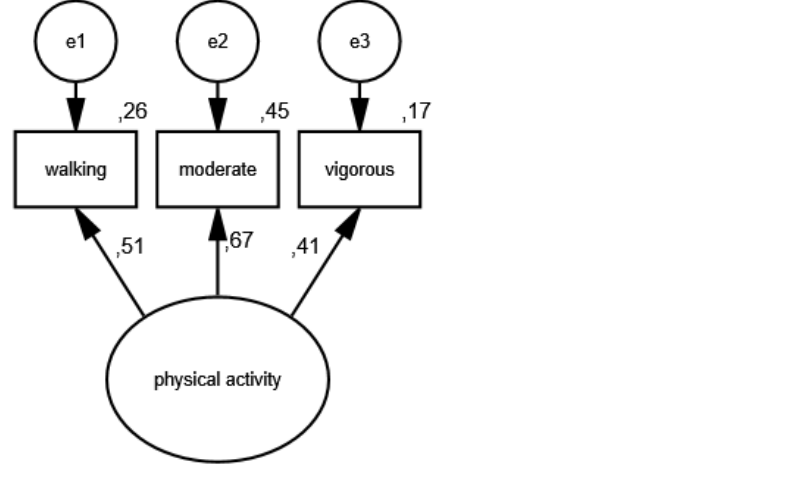
Figure 2. Standardized effects of the model of physical activity measurement in the group of men . As a result of the estimation, the following measures were obtained: CMIN/DF = 1.75; GFI = 0.99; AGFI = 0.99; NFI = 0.99; RFI = 0.95; IFI = 0.99; TLI = 0.99; CFI = 0.99; RMSEA = 0.001(0.001; 0.05); PCLOSE = 0.92; N HOELTER(1269; 1561), which confirm that the model reflects the nature of the relationships between the analyzed variablesvery well. The standardized values of factor loadings and the percentages of variances ex- plained in each of the analyzed groups show that the constructed model of physical ac- tivity measurement is acceptable. In the second measurement model, the presence of mental health disorders is an unobservable variable, and its partial indicators are somatic symptoms, anxiety and in- somnia, functional disorders and the symptoms of depression. The results of the verifi- cation of the constructed model for measuring mental health disorders in the group of women are shown in Figure 3, and Figure 4 illustrates the measurement model of mental health disorders in the group of men.